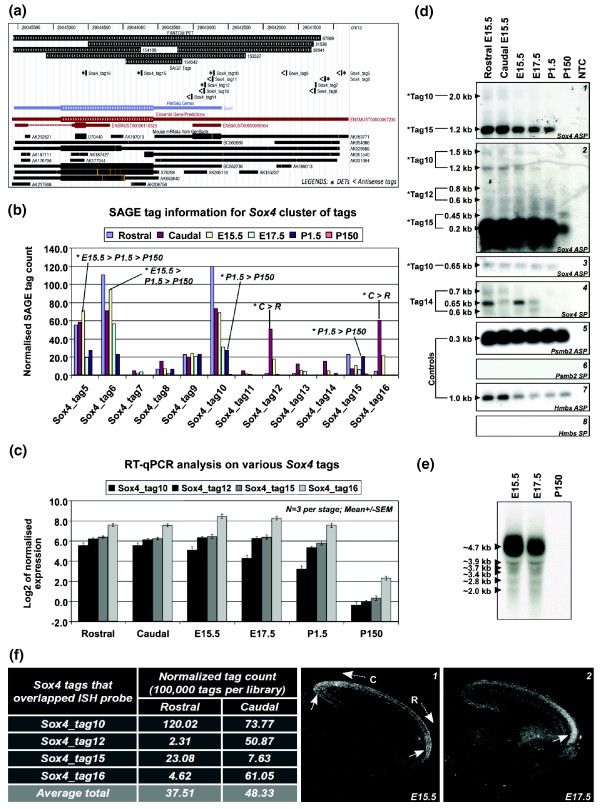
Genomic cluster at the Sox4 locus. (a) The UCSC genome browser of the over-represented Sox4 genomic locus. SAGE tags were found in both directions within the Sox4 reference gene. (b) The SAGE expression profiles for each tag in the Sox4 locus. (c) The RT-qPCR validations of selected DETs at various loci within the Sox4 canonical gene. (d) The 3' RACE-Southern blotting analysis. The left panel of the figure shows the sizes of the bands and their corresponding tags. (d1-d3) Amplification of Sox4 sense transcripts (ASP); (d4) amplification of Sox4 antisense transcripts (SP). Tags with asterisks are DETs. Both (d5) and (d7) are positive controls exclusively generated from the sense strand of Psmb2 and Hmbs housekeeping genes (ASP), respectively. The corresponding (d6) and (d8) are the antisense expression (negative control) of Psmb2 and Hmbs (SP), respectively. (e) Northern analysis of total RNA isolated from pooled mouse cerebral cortices (N = 7). (f) The regionalized expression of Sox4 sense transcripts determined by ISH. The table consists of SAGE information for related Sox4 sense tags at rostral and caudal regions of the E15.5 cerebral cortex. (f1) and (f2) are sagittal sections obtained from E15.5 and E17.5 mouse brains, respectively. The figures show the expression of the Sox4 sense transcript variants. Arrows show brain regions with greater Sox4 sense expression. C: caudal region of the cerebral cortex; R: rostral region of the cerebral cortex.